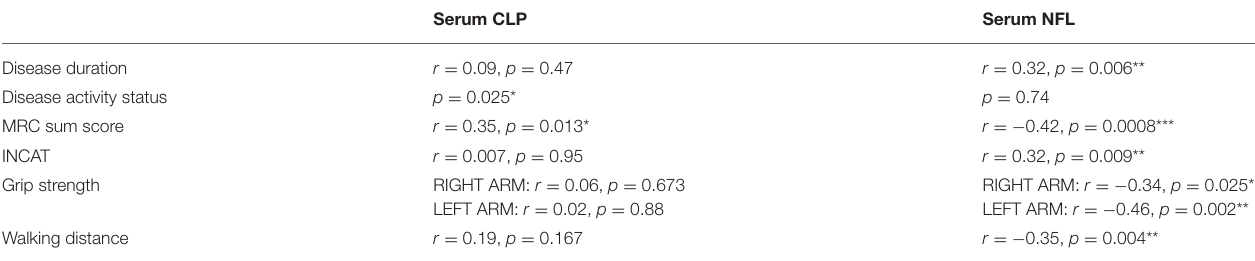
Serum CLP Serum NFL